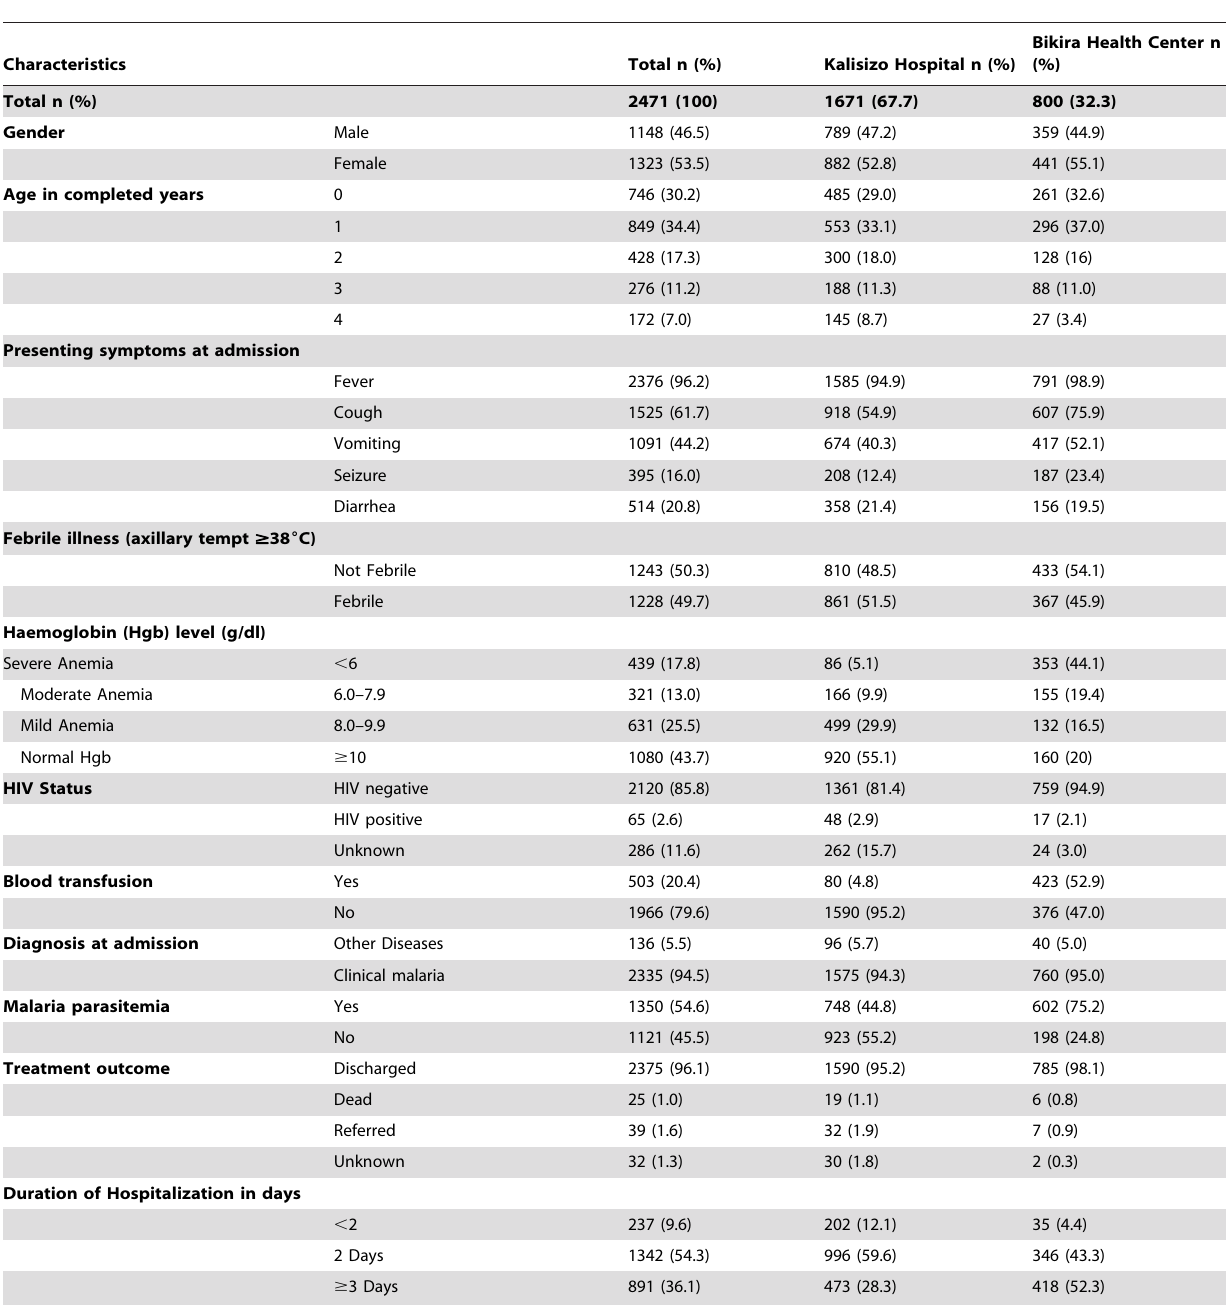
Table 1. Characteristics of children at hospitalization in Bikira and Kalisizo health centers.